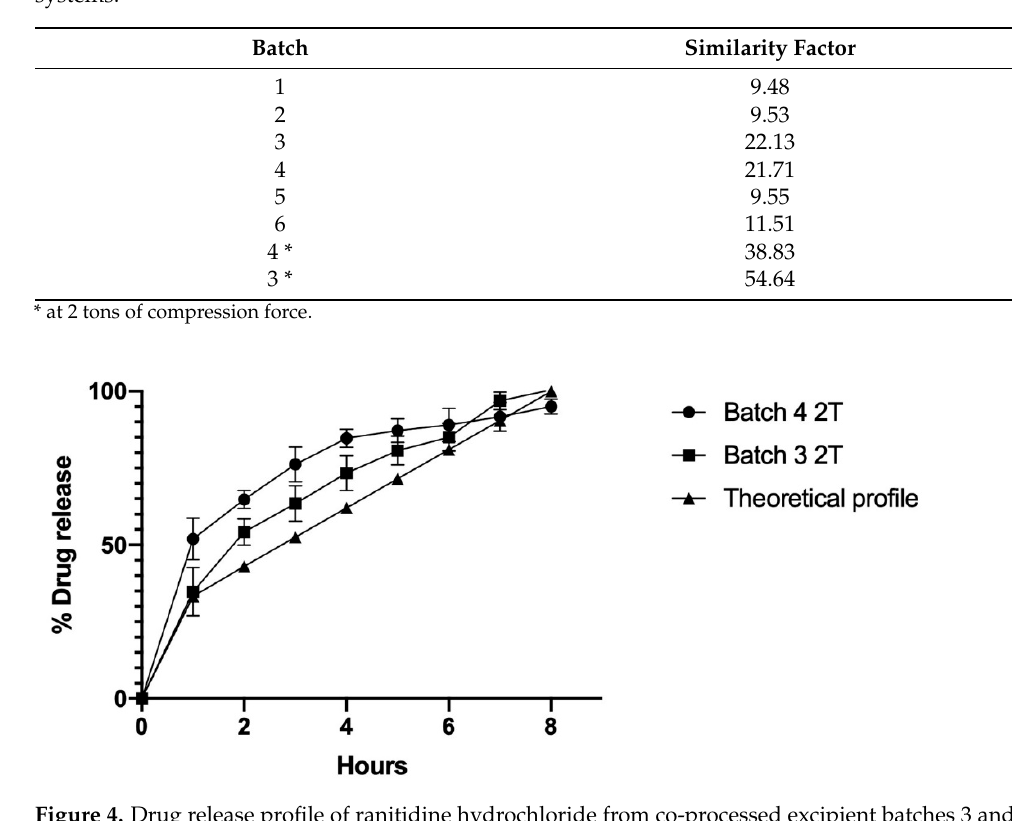
Figure 4. Drug release profile of ranitidine hydrochloride from co-processed excipient batches 3 and 4 at 2 tons of compression force.